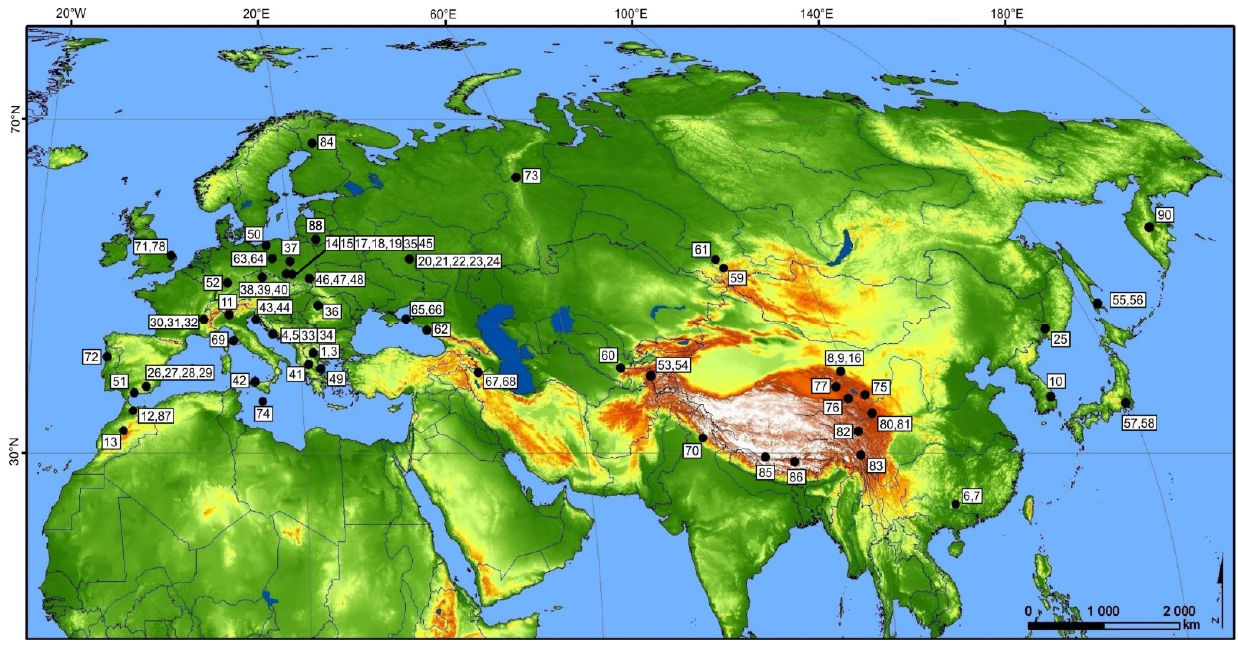
Figure 1. Collecting locality of specimens used in this study.